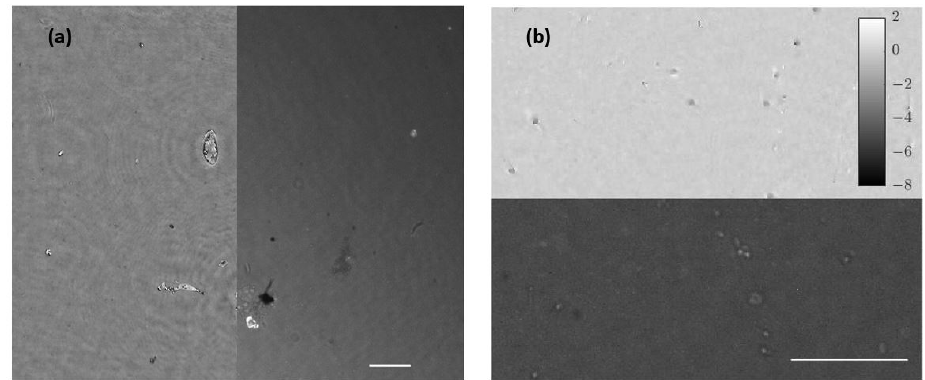
Figure 10. Movies of biological samples with the simultaneously combined image of holography and fluorescence. ( a ) Visualization of water suspended microorganism (Visualization 7 in the Sup- plementary Materials) where left half FOV shows the retrieved phase distribution and right half FOV includes the fluorescence direct image. ( b ) Spermatozoa in free movement (Visualization 8 in the Supplementary Materials) where bottom half FOV shows florescence and the upper half FOV includes phase distribution. White bars represent a length of 50